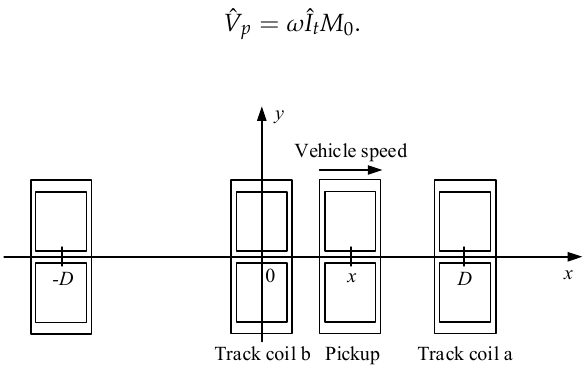
Figure 3. Coil layout of the wireless power transfer (WPT) system.